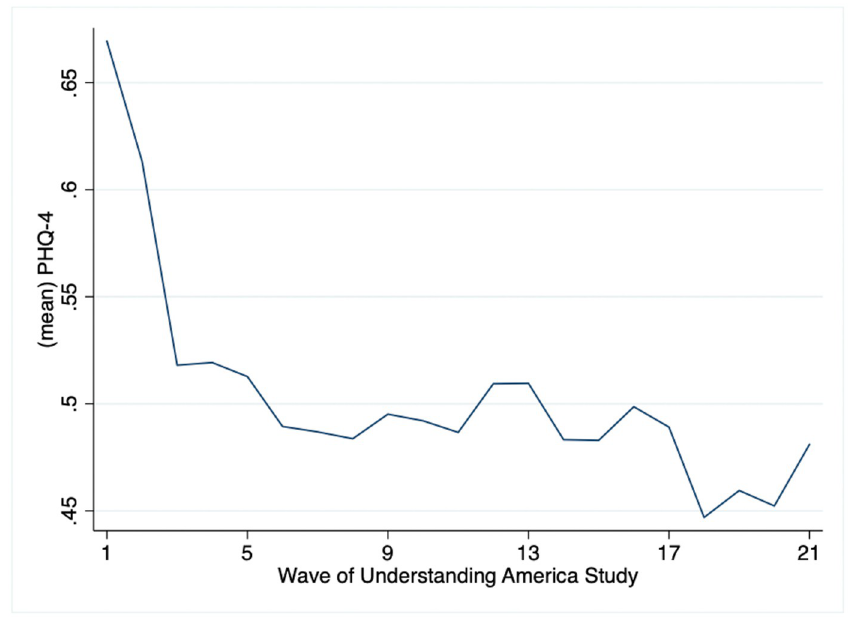
Fig 1. Changes in depressive symptoms, April 2020-February